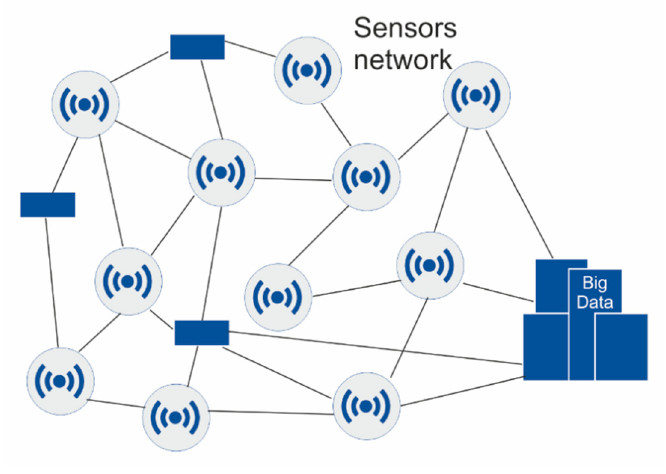
Figure 4. Sensors Figure 4. Sensors network.